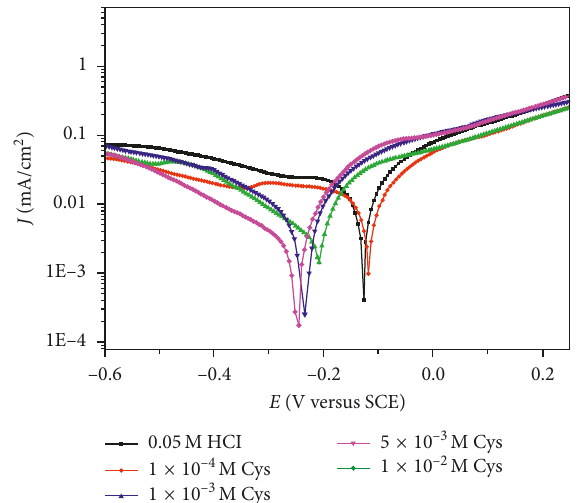
Figure 4: Polarization curves for brass in a 0.05M HCl solution in the presence of various concentrations of cysteine (scan rate, 1mV/s).